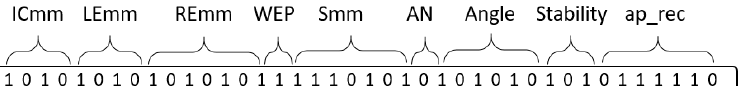
Figure 10. The GA chromosome structure.